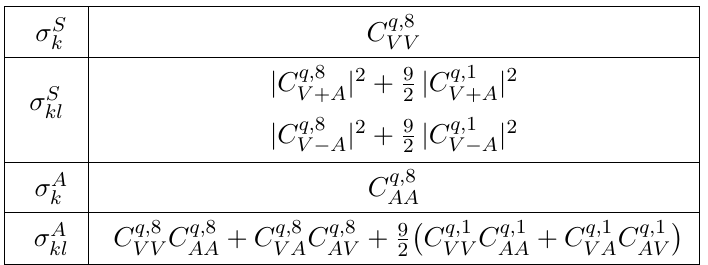
Table 3 . Four-quark contributions to t (cid:22) t production in SMEFT at LO QCD. We separate SM- interference, (cid:27) S;A , and dimension-6 squared terms, (cid:27) S;A k cross